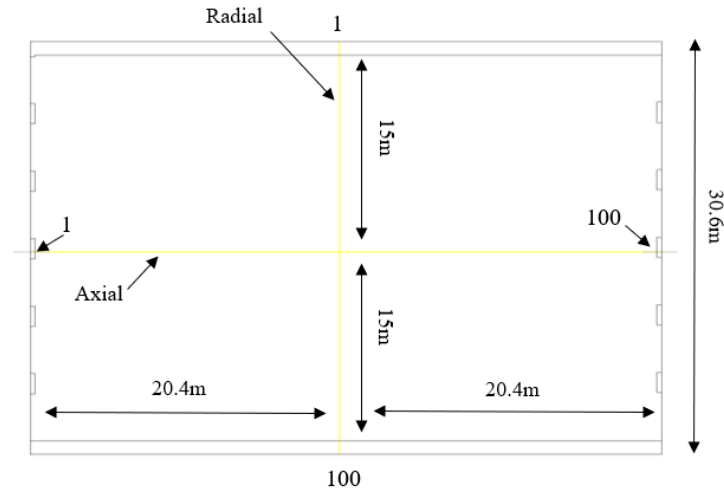
Figure 8. Axial and radial directions created across all the models.